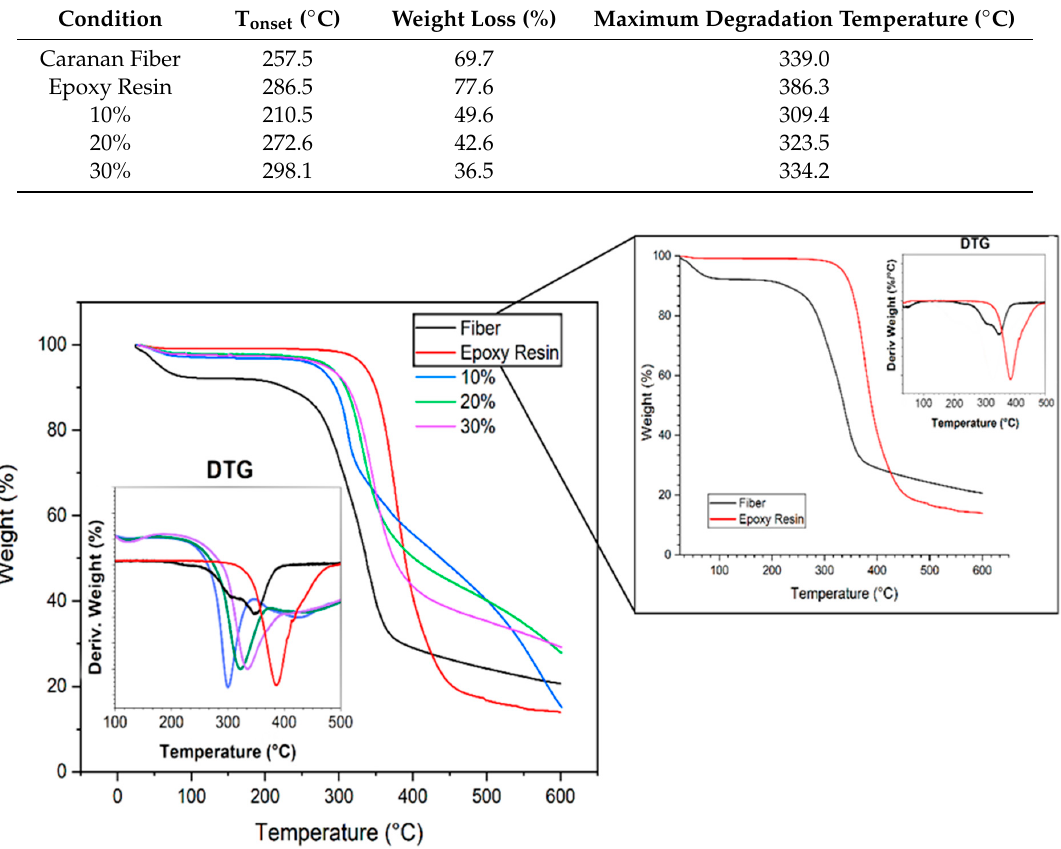
Figure 11. Thermogravimetric analysis (TGA) and derivative thermogravimetric (DTG) curves of caranan fiber, epoxy resin and their composites.